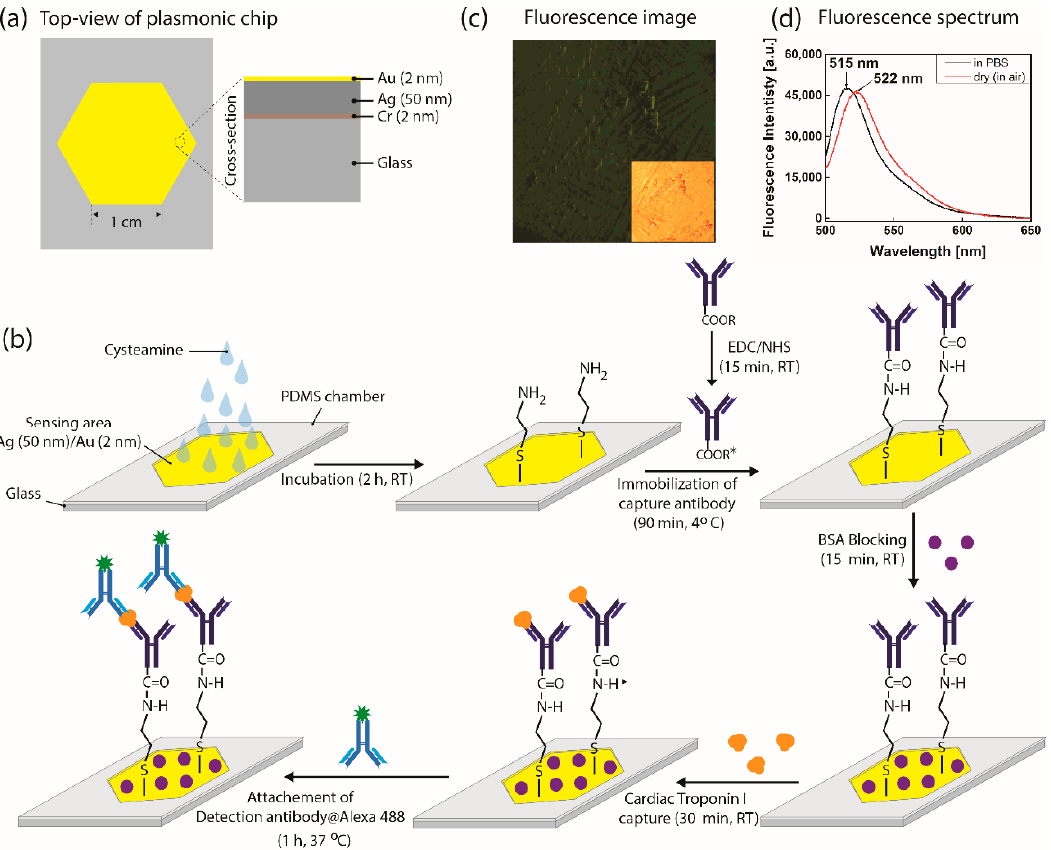
Figure 1. ( a ) Top-view and cross-section of the SPCE chip. ( b ) Procedures for the sandwich immune reaction for detecting cTnI. ( c ) Fluorescence microscope image of the green color due to fluorescence from the SPCE chip that went through the procedures of Figure 1b, under excitation (blue) light illumination (inset shows the image under white light illumination). ( d ) The fluorescence spectrum of Alexa 488 conjugated D-Ab of 1 µg mL − 1 in PBS solution and in air under illumination of LED at 470 nm wavelength.